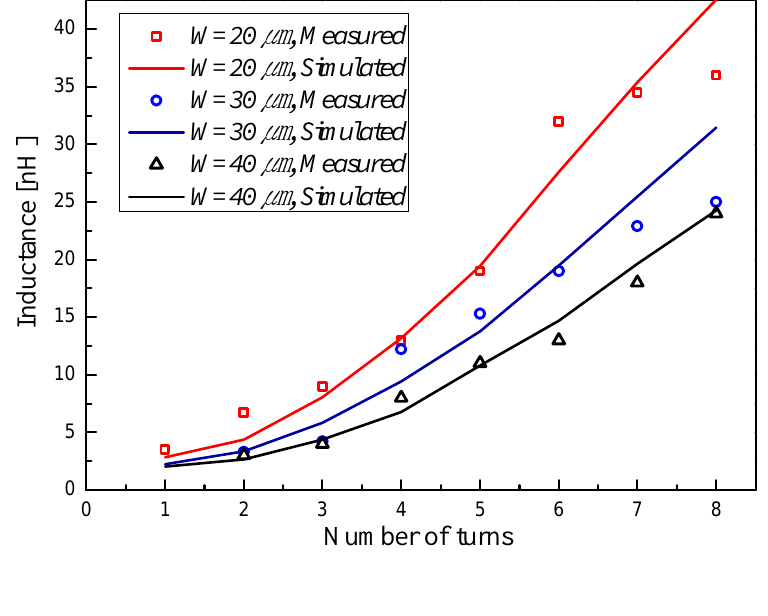
Figure 6. Comparison of the simulated inductance with the measured inductance of a planar spiral